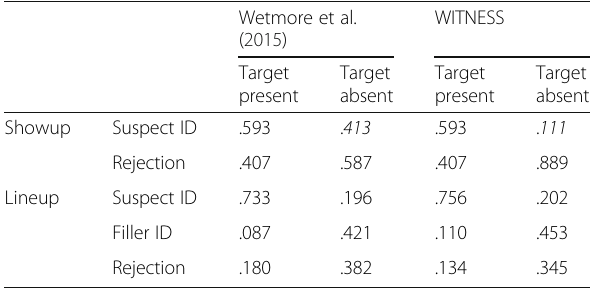
Table 1 Wetmore et al. (2015) simultaneous lineup and showup data collapsed over retention interval and lineup fairness accompanied by WITNESS predictions Wetmore et al. (2015)